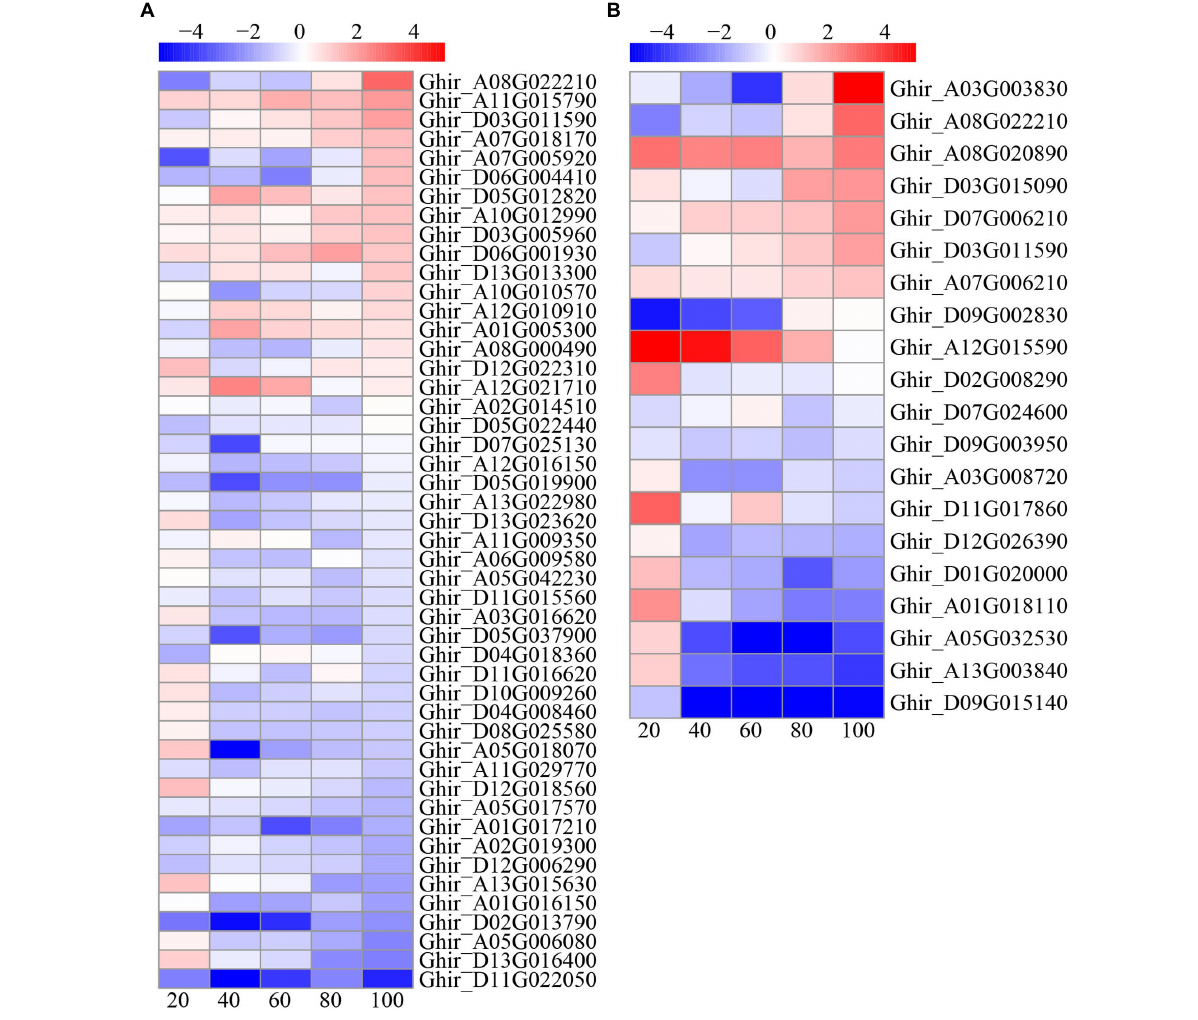
FIGURE 10 | Heatmap illustrating differential expression of carbon (A) and nitrogen (B) metabolism at 20, 40, 60, 80, and 100 days after emergence. Different scale color represents the size of log 2 fold change